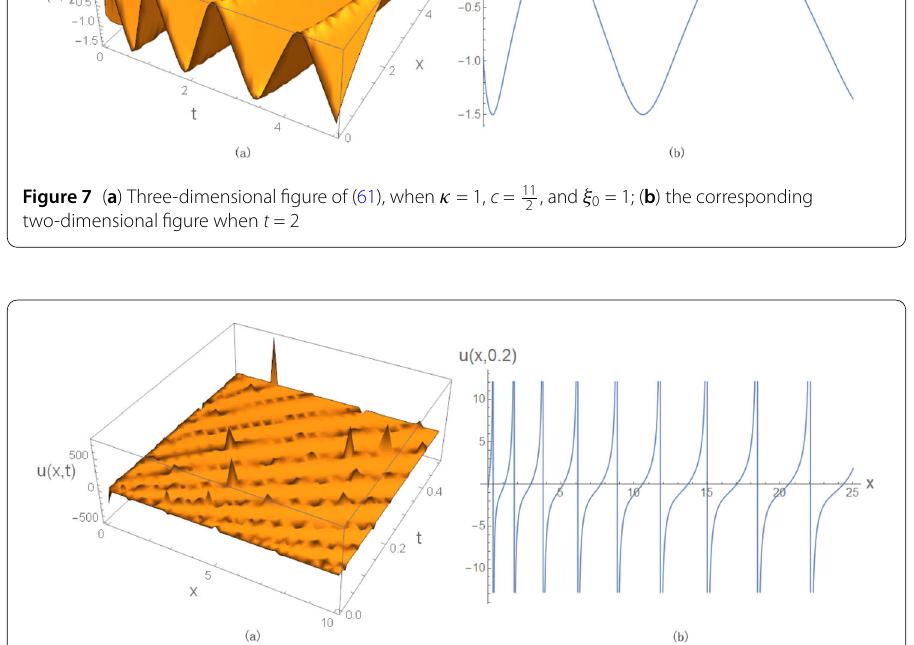
, and ξ 0 = 1; ( b ) the corresponding 2